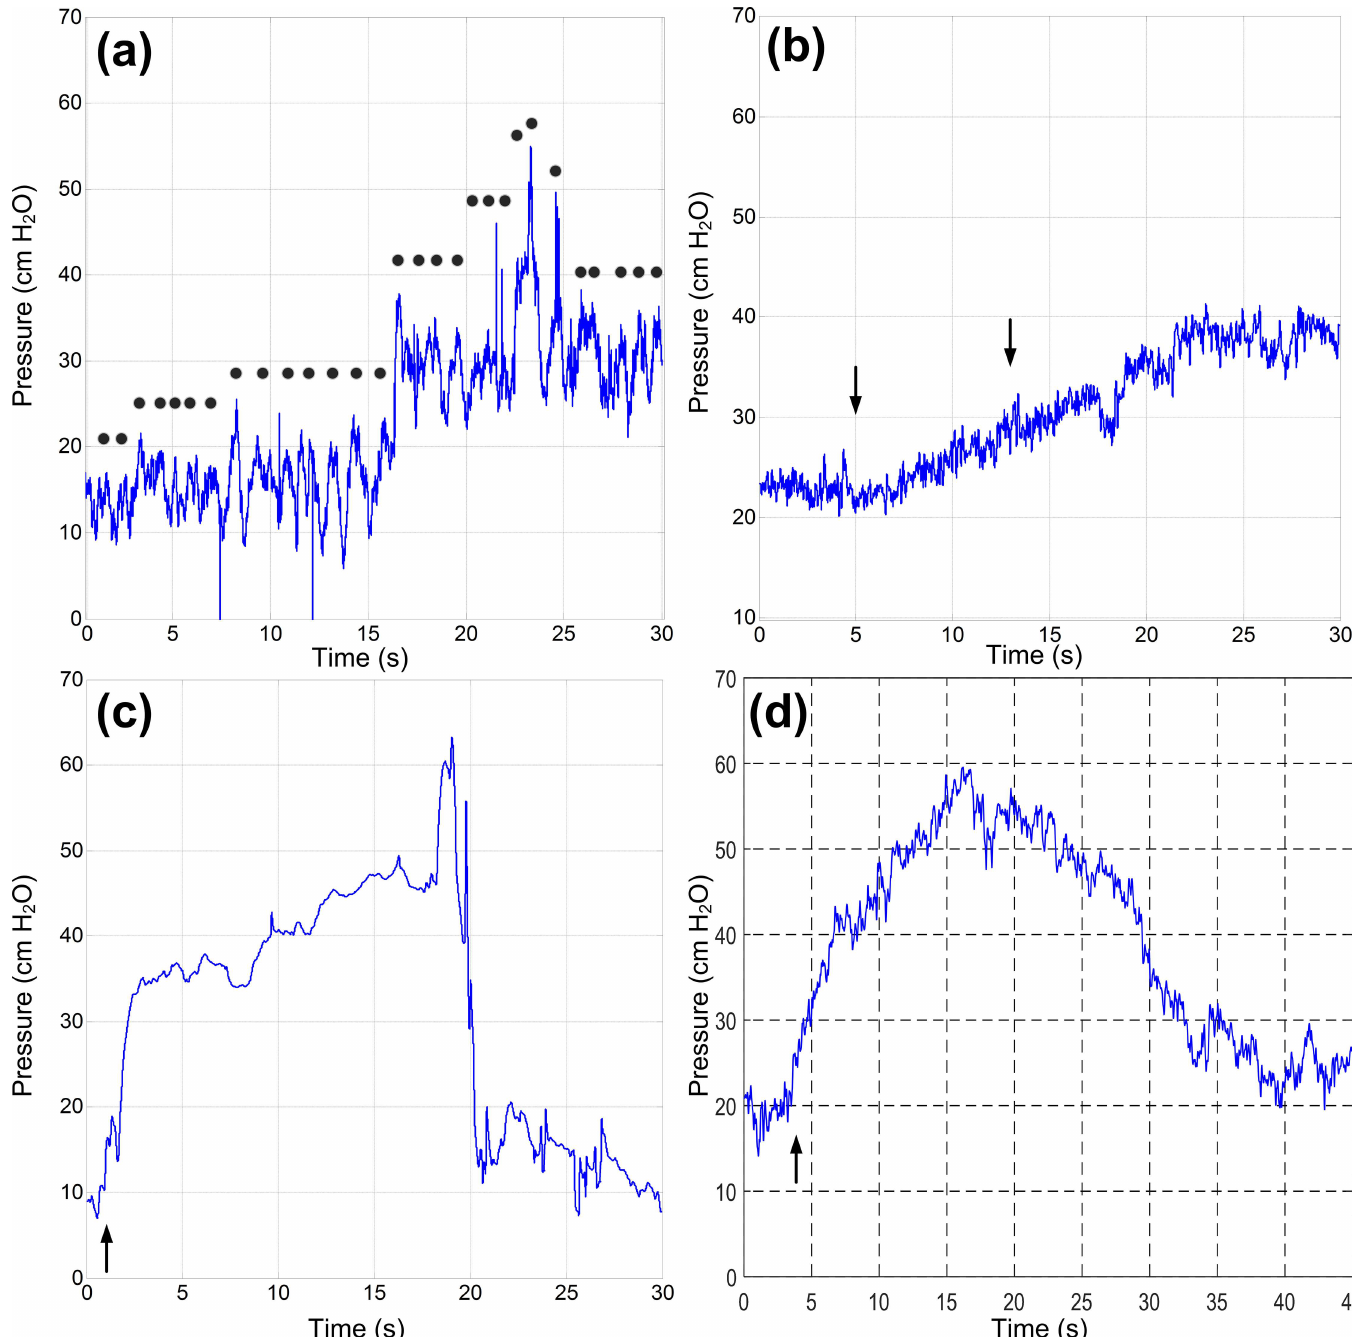
Fig 6. Examples of PressureData from the Device during Ambulation. Data capturedin the ambulatory canine due to (a) walking(step frequency indicatedapproximately by dots) and (b) sit-to-stand posture change (black arrows indicate approximate start/stop of motion). Bladdercontractions (onset denotedby black arrow) measured in ambulatory canineshowingboth (c) voidingand (d)